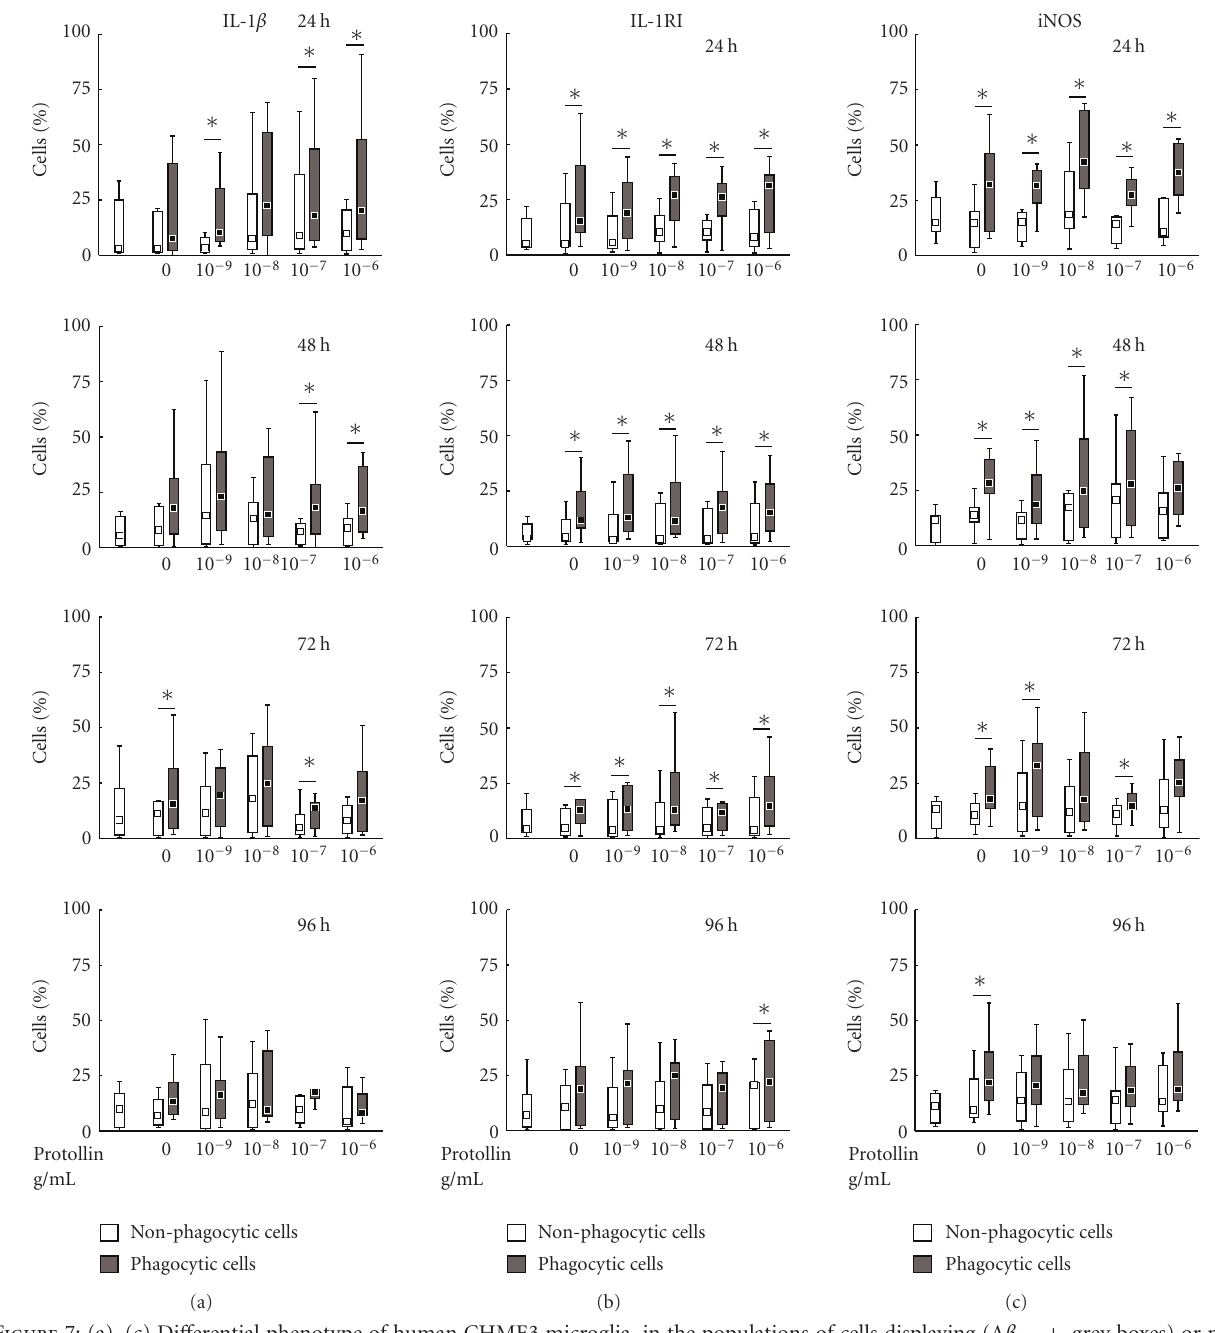
Figure 7: (a)–(c) Di ff erential phenotype of human CHME3 microglia, in the populations of cells displaying (A β 1 – 42 +, grey boxes) or not displaying (A β 1 – 42 − , white boxes) phagocytosis of A β 1 – 42 , with regard to immunoreactivity for interleukin-1 β (IL-1 β ), inducible nitric oxide synthase (iNOS), and IL-1 β receptor type I (IL-1RI), following pretreatment with Protollin (0.001–1 μ g/mL). After 24–96 hours of exposure to A β 1 – 42 , the cells were subjected to immunocytochemistry and analysed by flow-cytometry. The population of cells with immunoreactivity to the di ff erent markers within the A β 1 – 42 + cell population was compared with the corresponding population in the A β 1 – 42 − cell population in each treatment group, using the Wilcoxon Matched Pairs Test. The data are shown as median ± percentiles (25%–75% and 10%–90%), n = 7. Statistical di ff erences between the A β 1 – 42 + and A β 1 – 42 − cells with regard to each marker are indicated by ∗ ( P < . 05). treatments at one time point, and in one treatment at one time point, using Spearman’s Rank Order Correlation